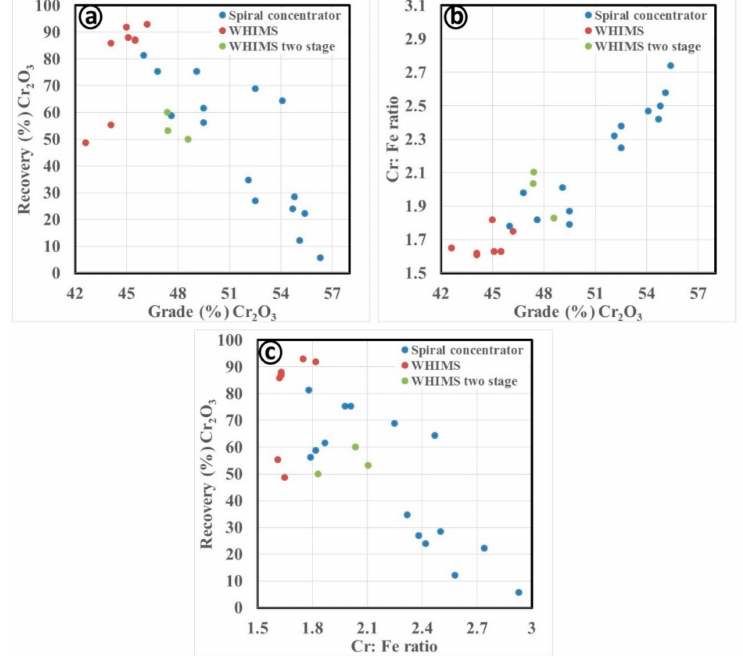
Figure 17. Comparison of the performance of the spiral concentrator and the WHIMS in treating ultrafine concentrate ( a ) for grade and recovery; ( b ) for grade and Cr:Fe rato; ( c ) for Cr:Fe rato and recovery.